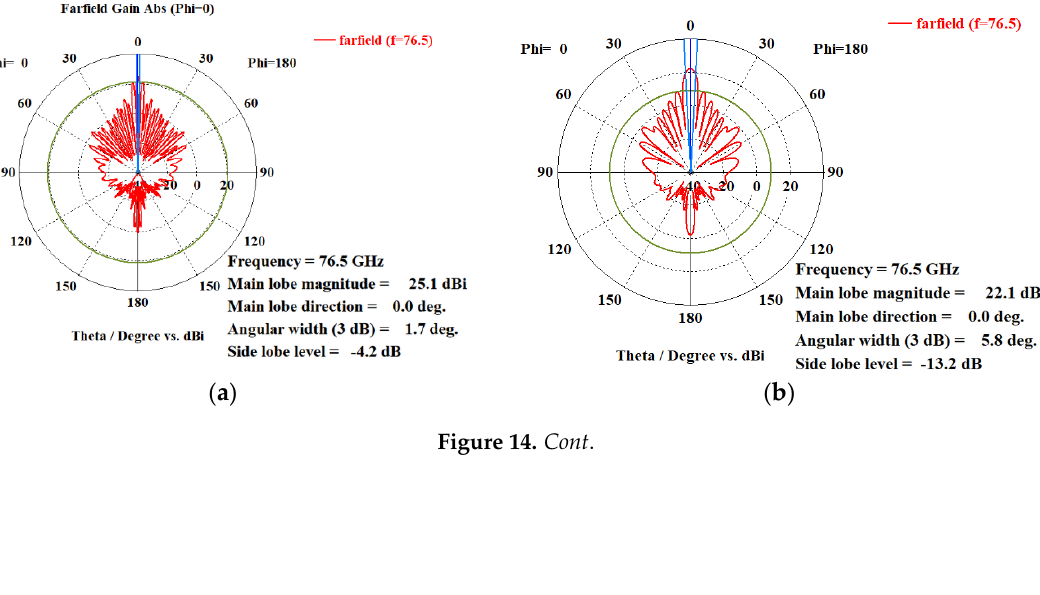
Figure 13. Antenna array configurations of the traditional TI’ LFMCW radar introduced in [31]: ( a ) transmitter array and ( b ) receiver array.